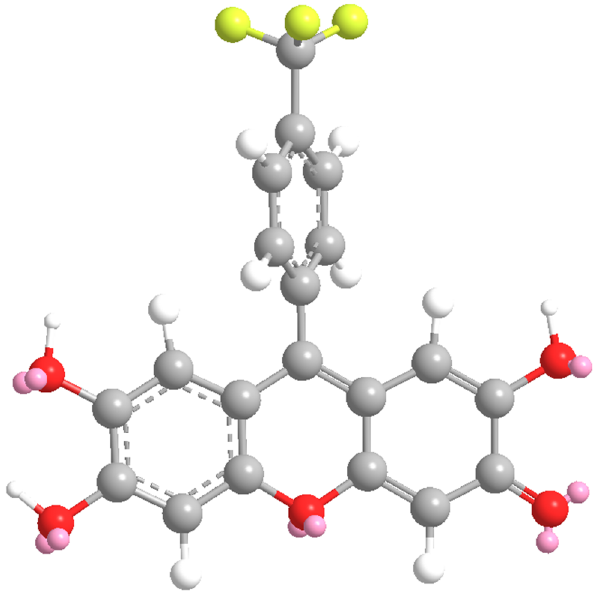
Figure 9. Energy minimization of the 4′-trifluoromethyl phenyl derivative 9 by MM2 force field method.